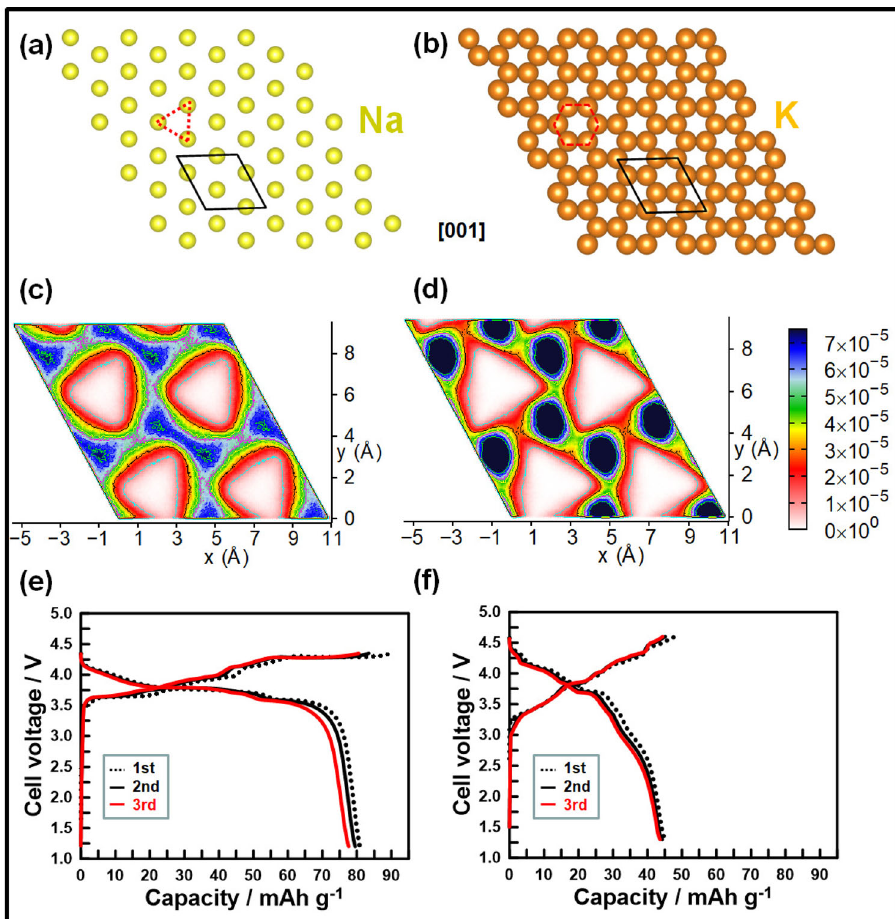
Fig. 4 Alkali ion transport in NaKNi 2 TeO 6 . a Arrangement of the Na atoms in triangular sites (as highlighted in red) as viewed along the [001] zone axis. The unit cell is highlighted in black lines. For clarity, the atoms denote the conformation of the sites and not the occupancy. b Honeycomb arrangement of K atoms in their respective sites as depicted along the [001] zone axis. c Molecular dynamics (MD) simulation showing the Na + ion probability density pro fi le in the Na-layer (mapped onto 2 × 2 unit cells) using common colour bars (shown on the right). The population contours re fl ects that the preferred migration pathway amongst the interstitial cationic sites. d MD simulation for K + ion probability density pro fi le in the K-layer. e Voltage pro fi les of the NaKNi 2 TeO 6 -based electrode tested using Na metal as counter electrode and Na 0.20 Pyr 0.80 FSI ionic liquid as electrolyte solution at 6.65 mA g – 1 and ( f ) Voltage pro fi les of the NaKNi 2 TeO 6 -based electrode tested using K metal as counter electrode and K 0.20 Pyr 0.80 FSI ionic liquid as electrolyte solution at 6.65 mA g – 1 . Voltage – capacity pro fi les set at a lower cut-off voltage of 2.5 V have been furnished in the Supplementary Information (Supplementary Fig.